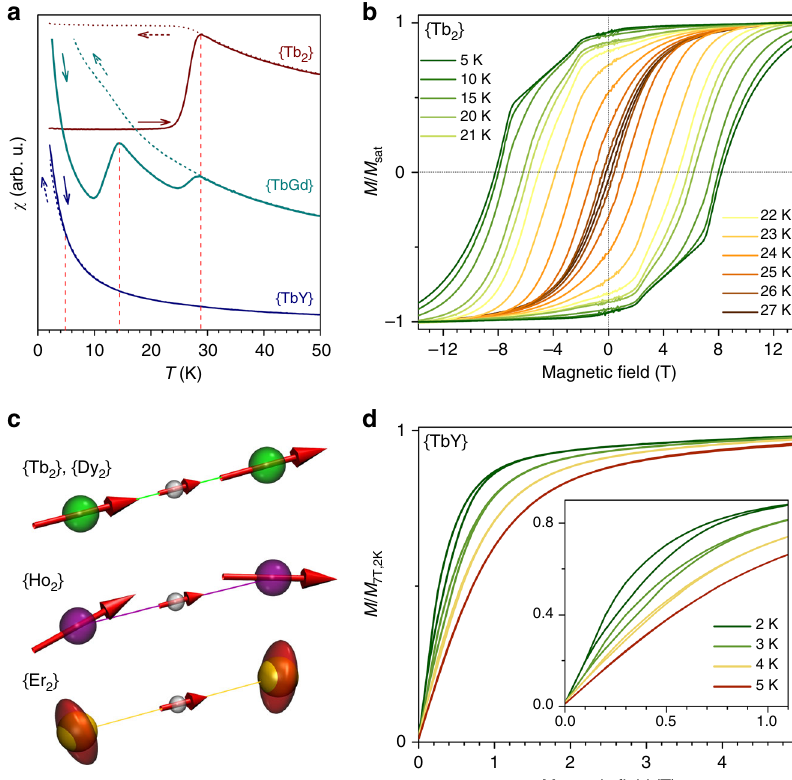
Fig. 4 Magnetic properties of {Ln 2 } molecules. a Blocking temperature of magnetization in {Tb 2 }, {TbGd} and {TbY}; dotted lines are measurements of magnetic susceptibility χ during cooling in the fi eld of 0.2 T, solid lines are measurements during heating in the fi eld of 0.2 T of zero- fi eld cooled samples (sweep rate 5 K min − 1 , arrows indicate direction of the measurement for each curve), vertical red dotted lines denote T B values; b magnetic hysteresis curves for {Tb 2 }, sweep rate 9.5 mT s − 1 ; c alignment of Ln magnetic moments in {Ln 2 } according to ab initio calculations: collinear in {Tb 2 } and {Dy 2 }, tilted in {Ho 2 } (the arrows indicate directions of the single-ion quantization axis for each Ho), easy-plane in {Er 2 }, in the latter the Ln spins are visualized as ellipsoids; d low-temperature magnetization curves for {TbY}, sweep rate 2.9 mT s − 1 ; the inset shows enhancement of the fi eld range, in which magnetic hysteresis is